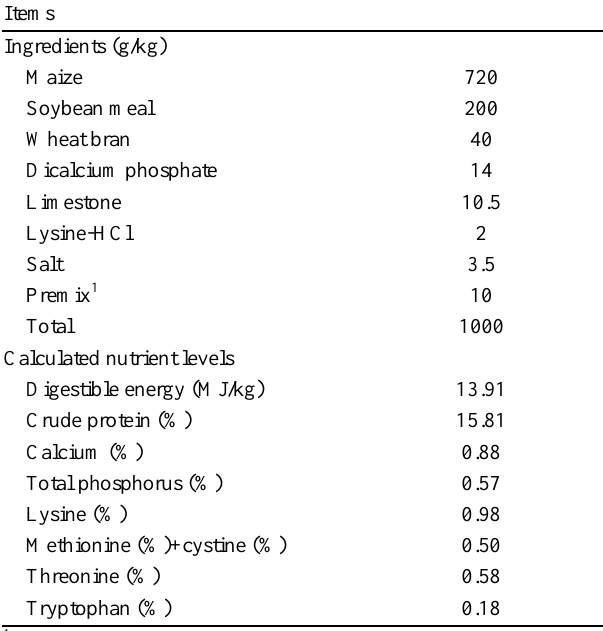
Table 1. The composition and nutrient level of the basal diet Items Ingredients